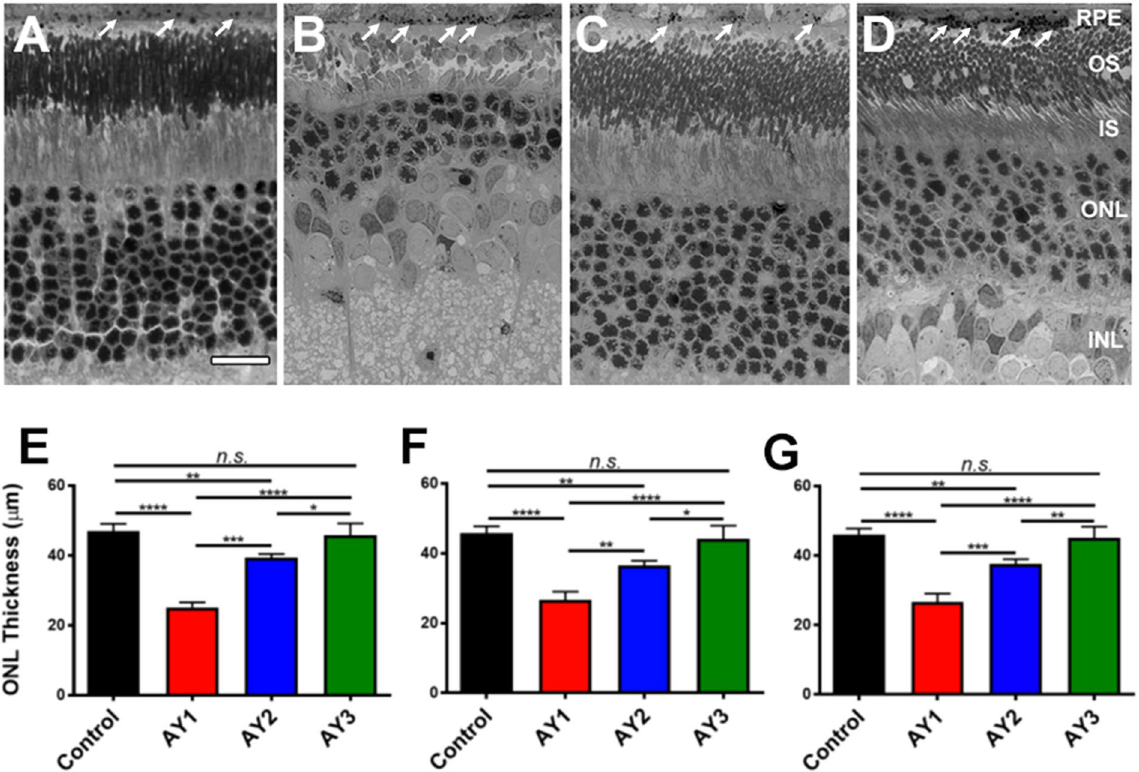
Figure 1. Retinal histology ( upper panels , A – D ) and quantitative morphometric analysis of ONL thickness ( lower panels , E – G ) of control vs . AY9944-treated rats on various diets. Light microscopy images (resin embedment, Toluidine blue stain; 40X objective) at age PN 80 days, under the following conditions: ( A ) Untreated rat fed a standard rodent diet (C1 group; black ); ( B ) AY9944-treated rat fed a CHOL-free rodent diet (AY1 group; red ); ( C ) AY9944-treated rat fed high-CHOL diet (AY2 group; blue ); and ( D ) AY9944-treated rat fed high-CHOL diet supplemented with antioxidants (AY3 group; green ). Presumed phagosomes in RPE are denoted by white arrows. Abbreviations : RPE, retinal pigment epithelium; OS, outer segment layer; IS, inner segment layer; ONL, outer nuclear layer; INL, inner nuclear layer. Scale bar ( panel A, for all panels), 20 μ m. ONL thickness measurements from ( E ) superior hemisphere, ( F ) inferior hemisphere, and ( G ) combined mean values (both hemispheres, ± S.E.M.; n = 3–4 biological replicates, n = 10 technical replicates, each condition), along the vertical meridian. Statistical significance (one-way ANOVA): * p < 0.05, ** p < 0.01, *** p < 0.005, **** p < 0.001; n.s., not